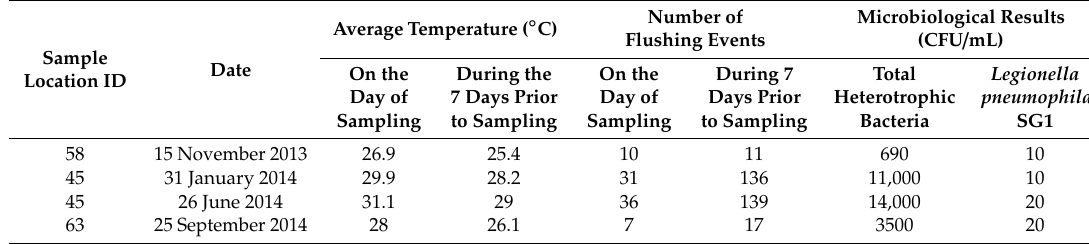
Table 1. Temperature, flow events and total heterotrophic bacteria counts for samples which were positive for L. pneumophila serogroup